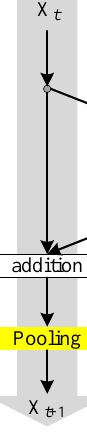
Figure 3. Simplified residual block.